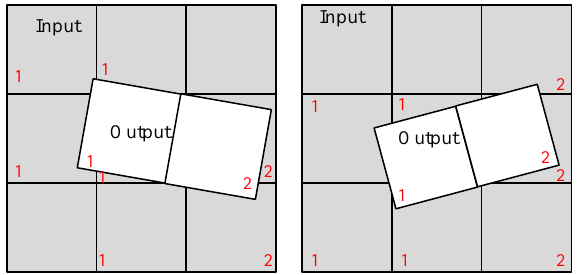
Figure 10. Image block read order. Label 1 in the gray-colored block is the input data that has been read, label 1 in the white-colored block is the currently calculated output image, label 2 in the white-colored block is the next output image block to be calculated, and label 2 in the gray-colored blocks is the data that must be read.